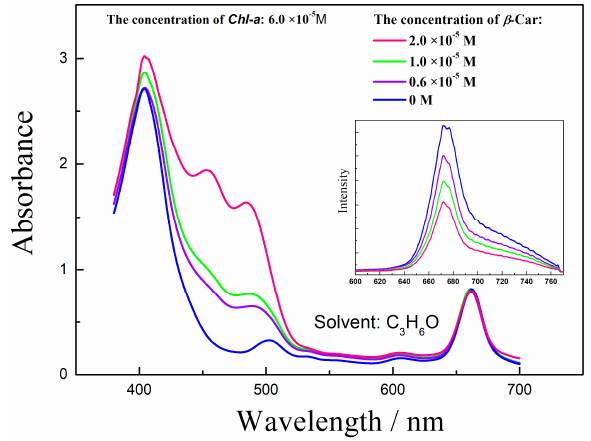
Figure 1. Absorption spectra of Chl-a and β -Car mixing solution, inset: the corresponding Chl-a fluorescence emission. The excited wavelength of the emission is 532 nm.